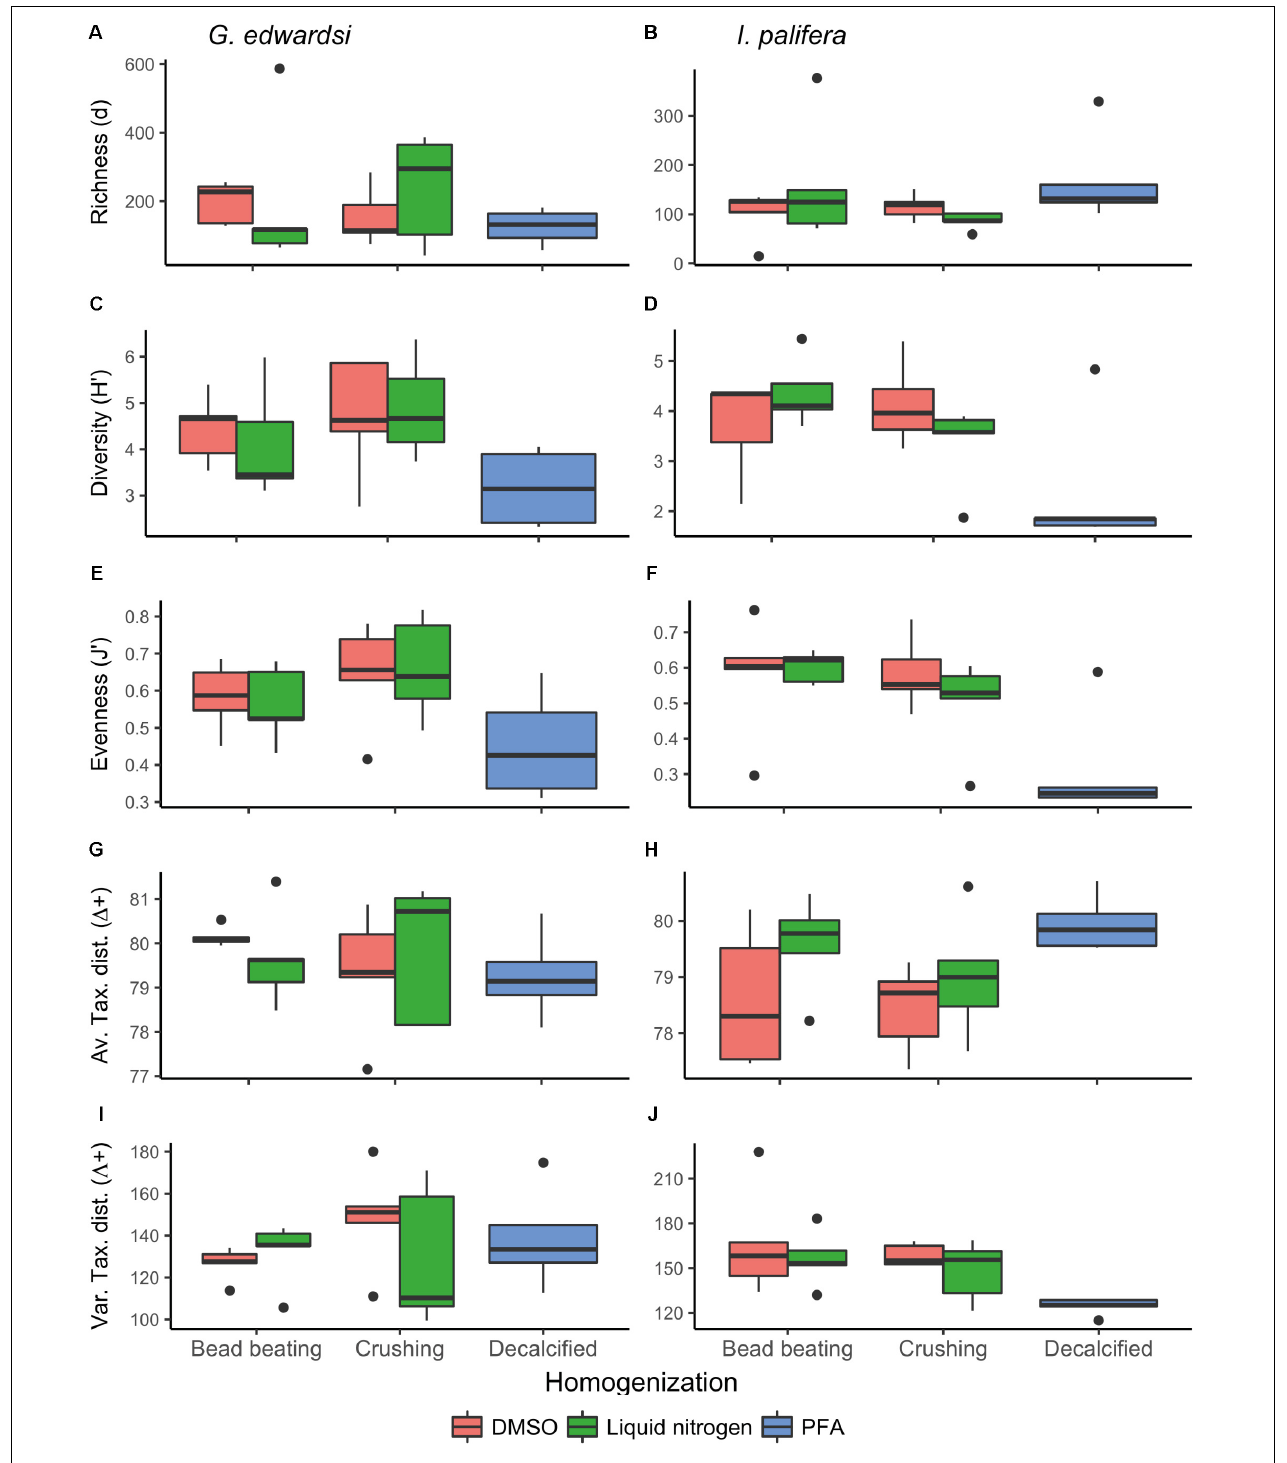
FIGURE 2 | Diversity metrics for Goniastrea edwardsi (A,C,E,G,I) and Isopora palifera (B,D,F,H,J) microbiome. No significant differences were detected in the diversity metrics of G. edwardsi microbiome ( Supplementary Table 1 ). I. palifera microbiome showed differences between fragments preserved with PFA and DMSOCr in evenness, average, and variation of taxonomic distinctness, and LNBB in evenness and variation of taxonomic distinctness (PERMANOVA, Supplementary Table 2 ). Richness (d): Margalef’s index, Diversity (H (cid:48) ): Shannon diversity, Evenness (J (cid:48) ): Pielou’s evenness, Av. Tax. dist. ( (cid:49) + ): Average of taxonomic distinctness, Var. Tax. dist. ( (cid:51) + ): Variation of taxonomic distinctness. Boxplots are based on raw data after excluding chloroplast, mitochondria, unidentified, and unassigned OTUs.